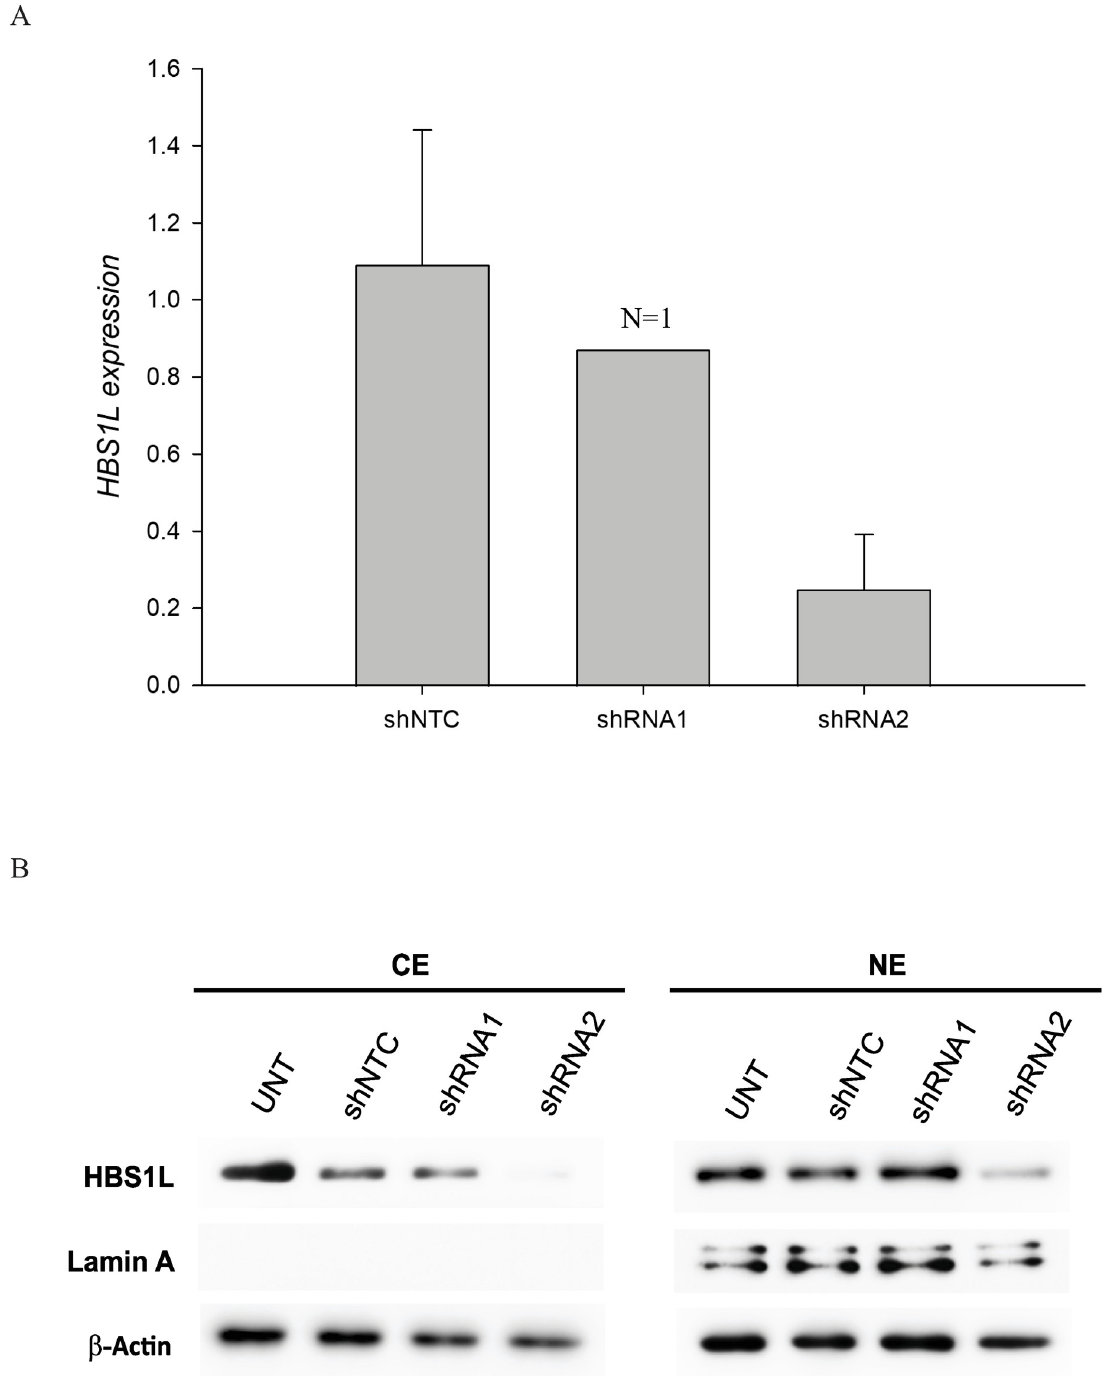
Fig 3. Comparison of HBS1L shRNA effectiveness. The scale bars represent Means ± SD. Effectiveness of HBS1L knockdown by shRNAs (A). Western blot was performed on cultured day 8 healthy erythroblasts transduced with HBS1L shRNA1, shRNA2 and shNTC and untransduced cells (UNT) (B). CE represented cytoplasmic extraction and NE for nuclear extraction, using β -actin and lamin A as a loading